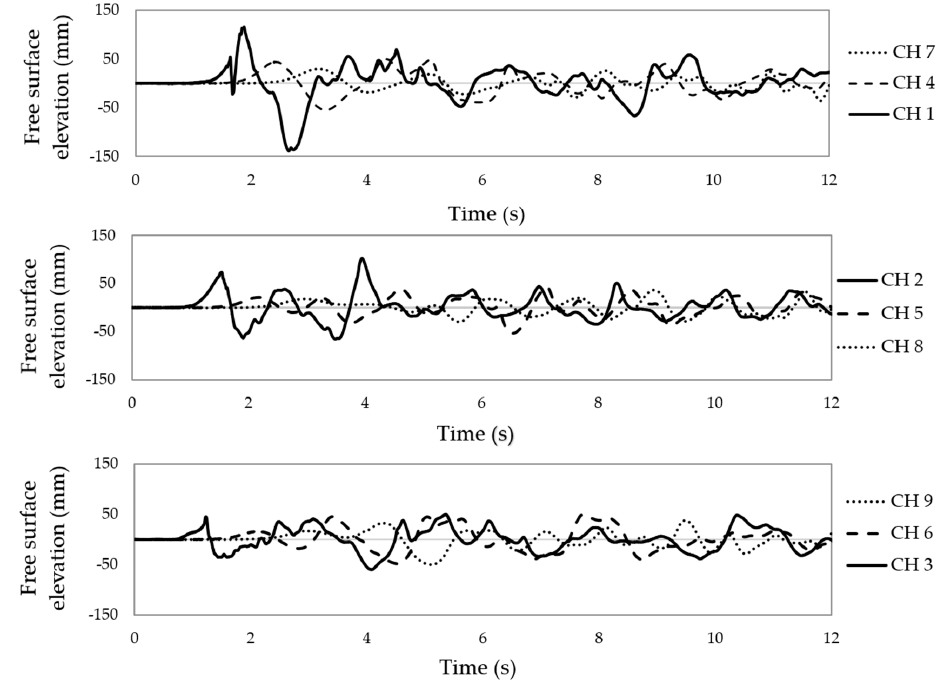
Figure 10. Wave profiles measured with the wave gauge sensors (see Figure 6 for the locations of the sensors) (Test no. 185_2.25s_4.5_2H_200).